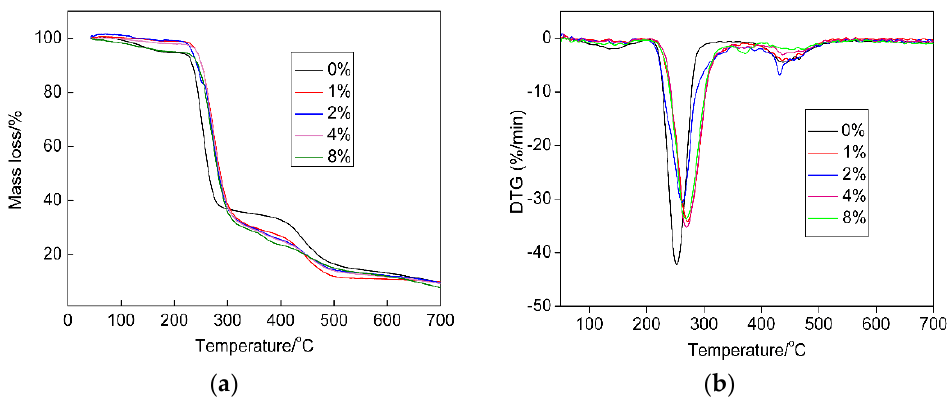
Figure 2. TG and DTG curves of as-prepared membranes (after 100 ◦ C treatment). ( a ) TG curves; ( b ) DTG curves.